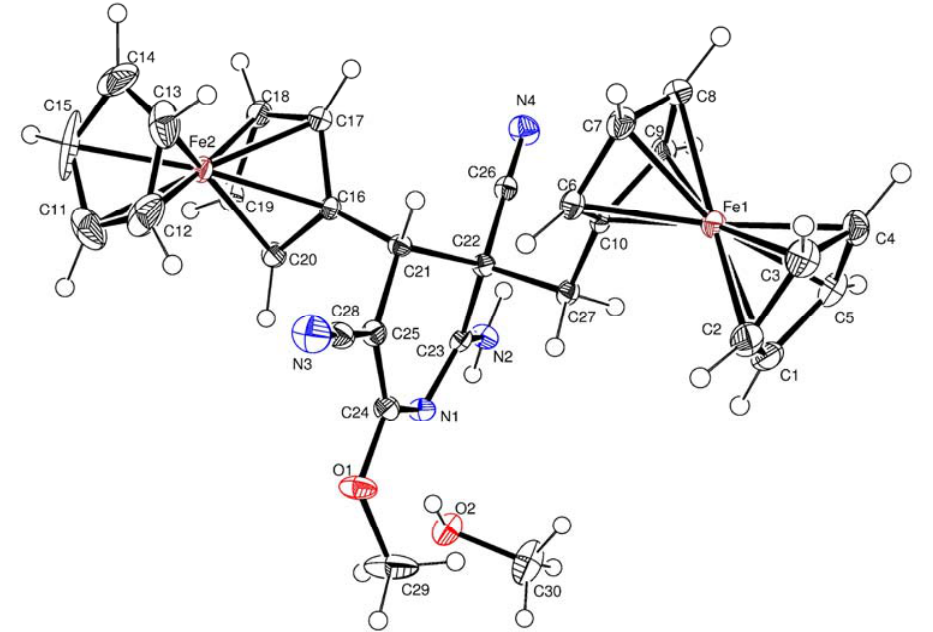
Figure 2. Crystal structure of 4a .